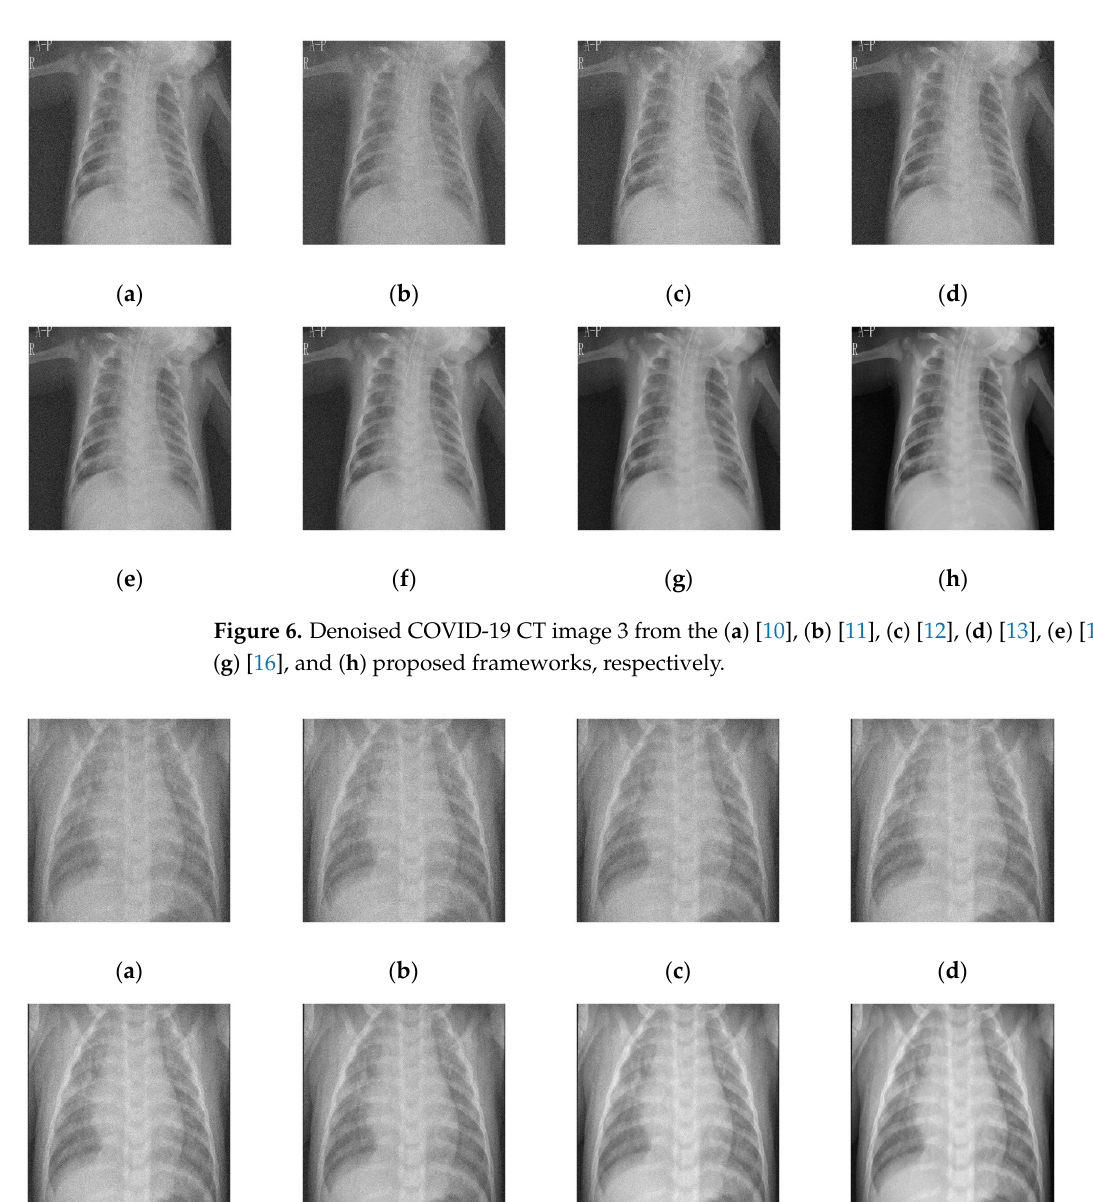
( h ) Figure 5. Denoised COVID ‐ 19 CT image 2 for the ( a ) [10], ( b ) [11], ( c ) [12], ( d ) [13], ( e ) [14], ( f ) [11], ( g ) [16], and ( h ) proposed frameworks, respectively. In Figure 5, the frameworks deal with images that need more contrast preservation and heterogeneous integrity. Figure 5a, corresponding to [10], gave the worst output, with